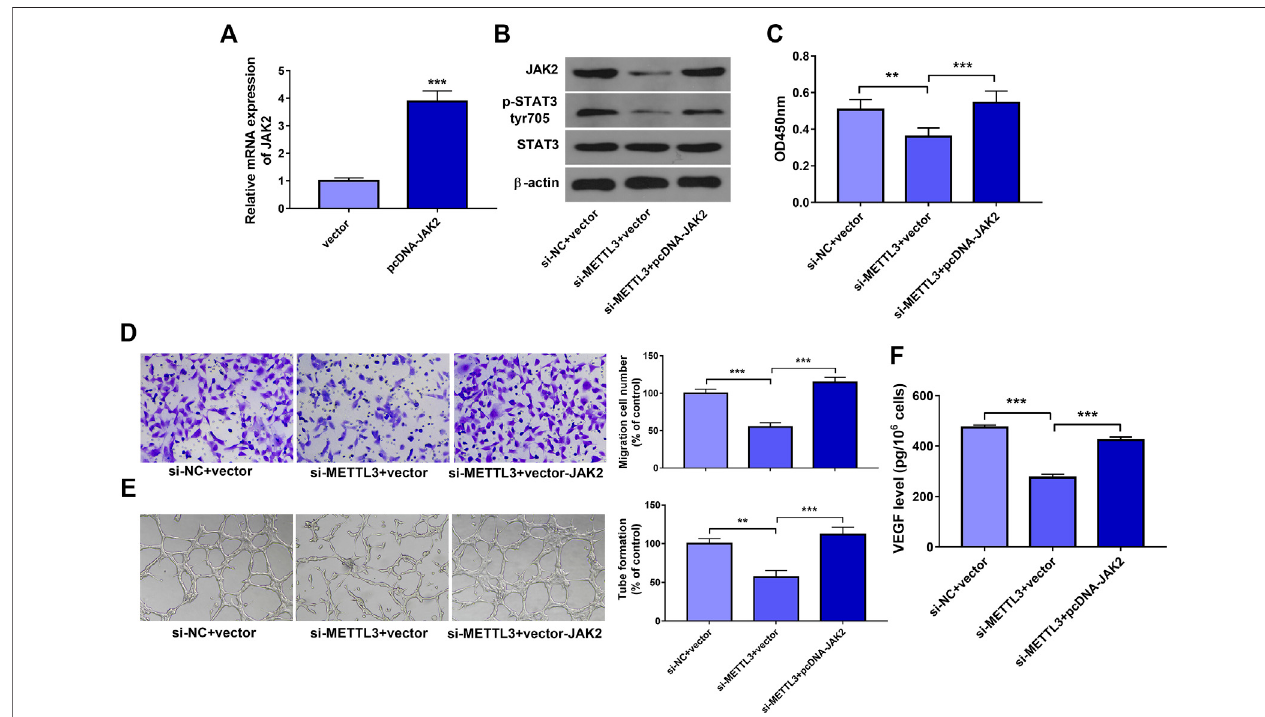
FIGURE 5 | METTL3 exerted its functions by regulating JAK2 expression and JAK2/STAT3 pathway. (A) HUVECs were transfected with pcDNA-JAK2 plasmid or empty vector. Forty-eight hours later, JAK2 mRNA level was measured by RT-qPCR assay. (B – F) HUVECs were co-transfected with si-NC + pcDNA3.1, si- METTL3+pcDNA3.1,orsi-METTL3+pcDNA-JAK2for24 h andthen stimulatedwithox-LDL. At24 hafter ox-LDL treatment,JAK2, p-STAT3,and STAT3 protein levels (B) ,cellproliferative (C) andmigratory (D) capacities,andVEGFsecretionlevel (F) weremeasured. (E) At12 hafterox-LDLtreatment,tubeformationpatternswere measured. Three independent experiments were performed for all in vitro assays. ** p < 0.01, *** p <